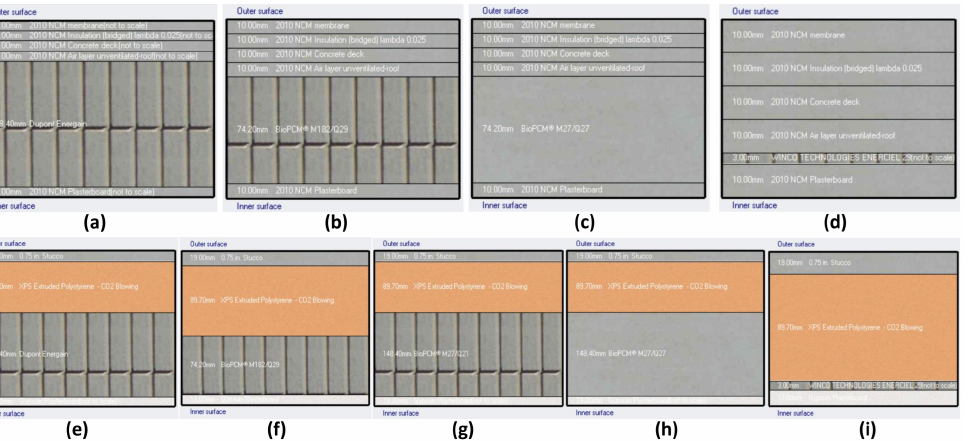
Figure 3. Five different standard PCM-based layouts tested [9]. For the roof layout: ( a ) Q25 Dupont Energain, ( b ) M182/Q29, ( c ) m 2 7/Q27, and ( d ) Winco Q29. For external-wall layout: ( e ) Q25 Dupont Energain, ( f ) M182/Q29, ( g ) m 2 7/Q21, ( h ) m 2 7/Q27, and ( i ) Winco